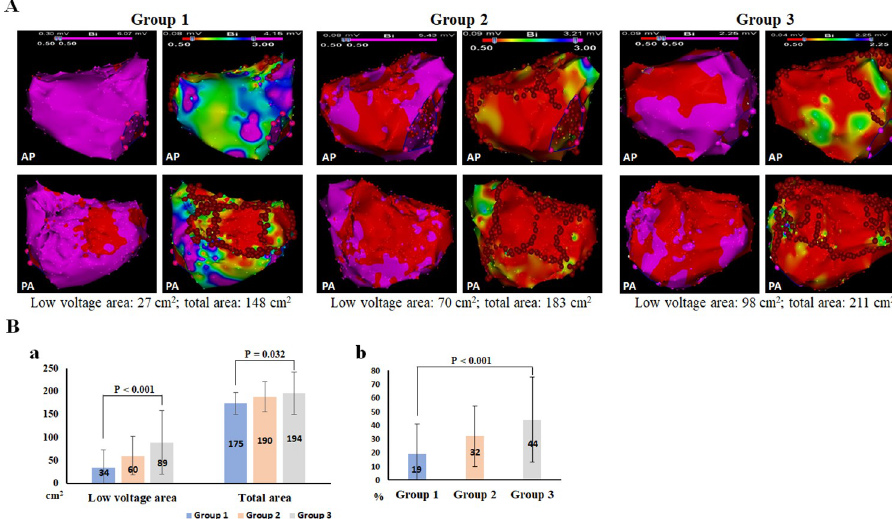
Fig 1. Examples of voltage maps and low-voltage area (LVA)-guided linear ablation in the three groups. A: Left subpanels show the distribution of LVA and right subpanels show linear ablation locations (red dots). As shown in right subpanels, the ablation lines were Compared with patients in Groups 2 and 3, patient in Group 1 showed a less extent of LVA and linear ablation was not performed at the mitral isthmus under LVA guidance. B: Summarized results of LVA (left), total left atrial area (right, subpanel a), and percentage of LVA relative to total left atrial area (subpanel b) in the three groups. AP, antero-posterior; PA: posteroanterior.